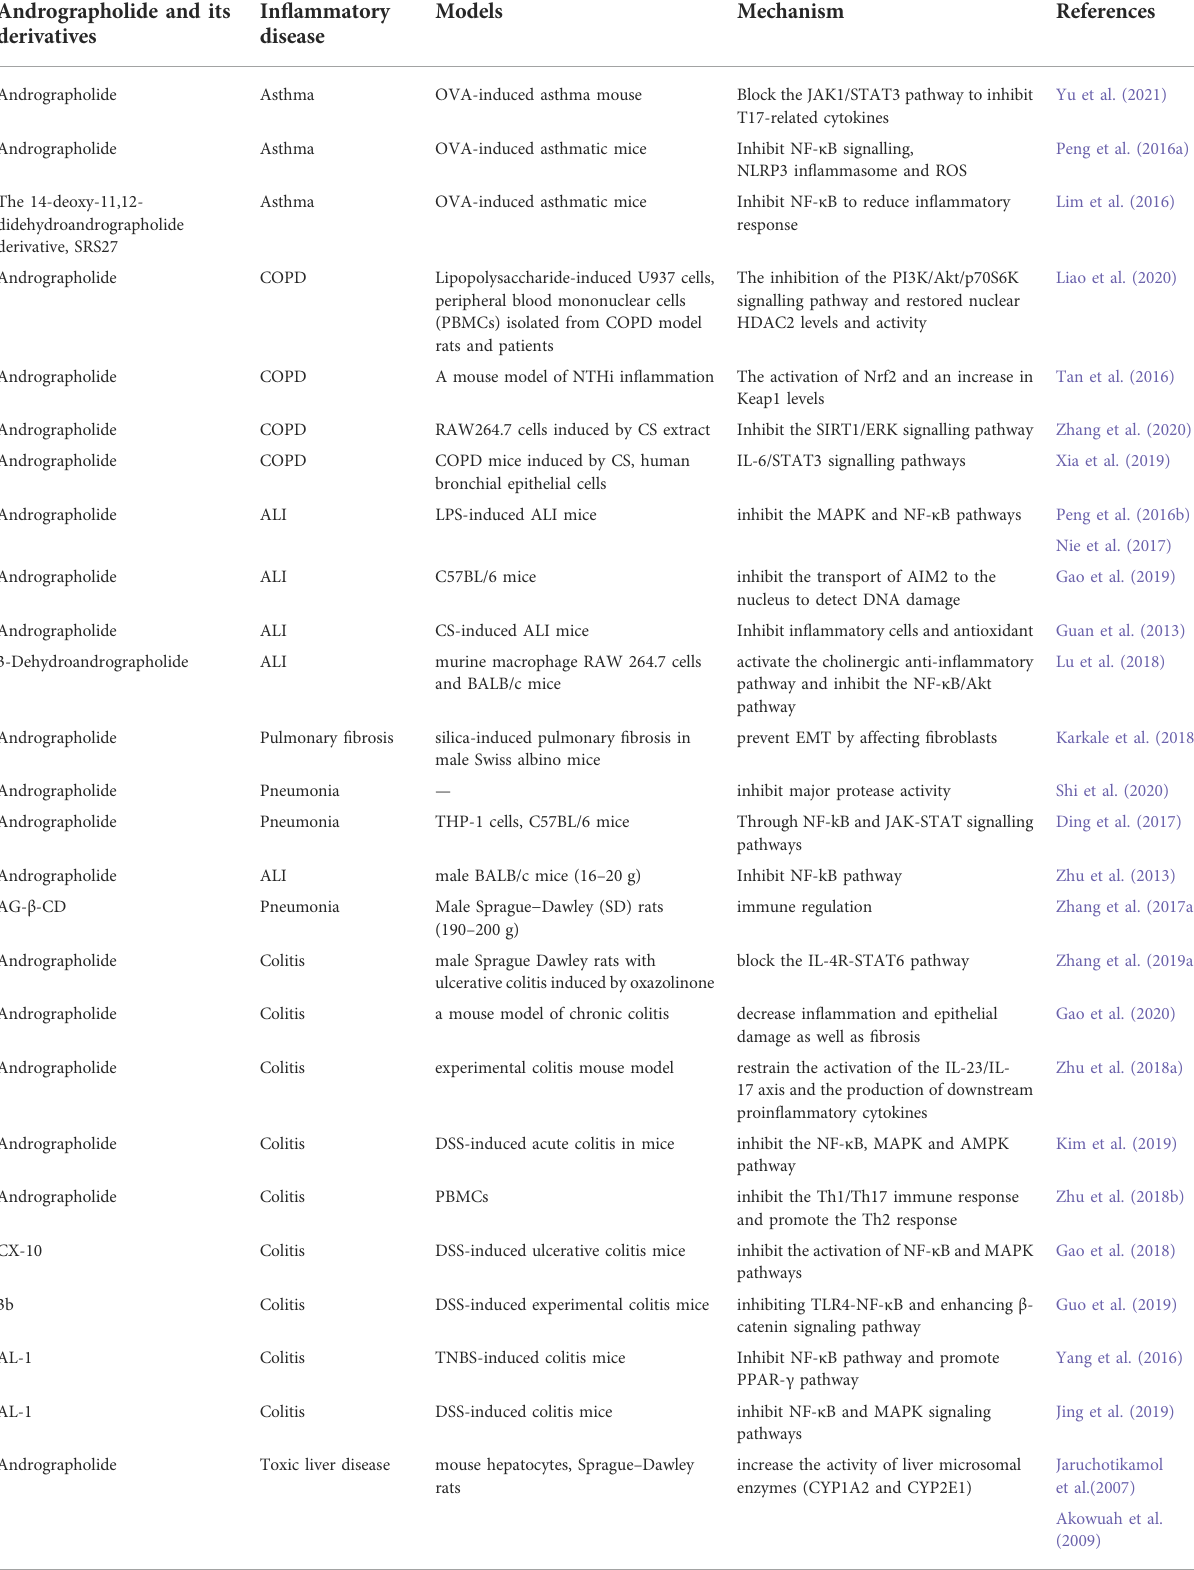
TABLE 1 Application and mechanism of andrographolide and its derivatives in in fl ammatory